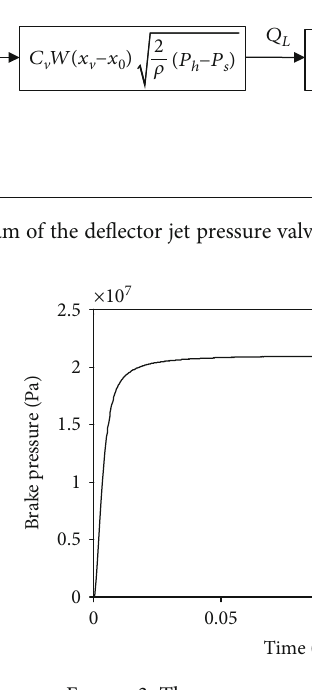
Figure 3: The pressure response of